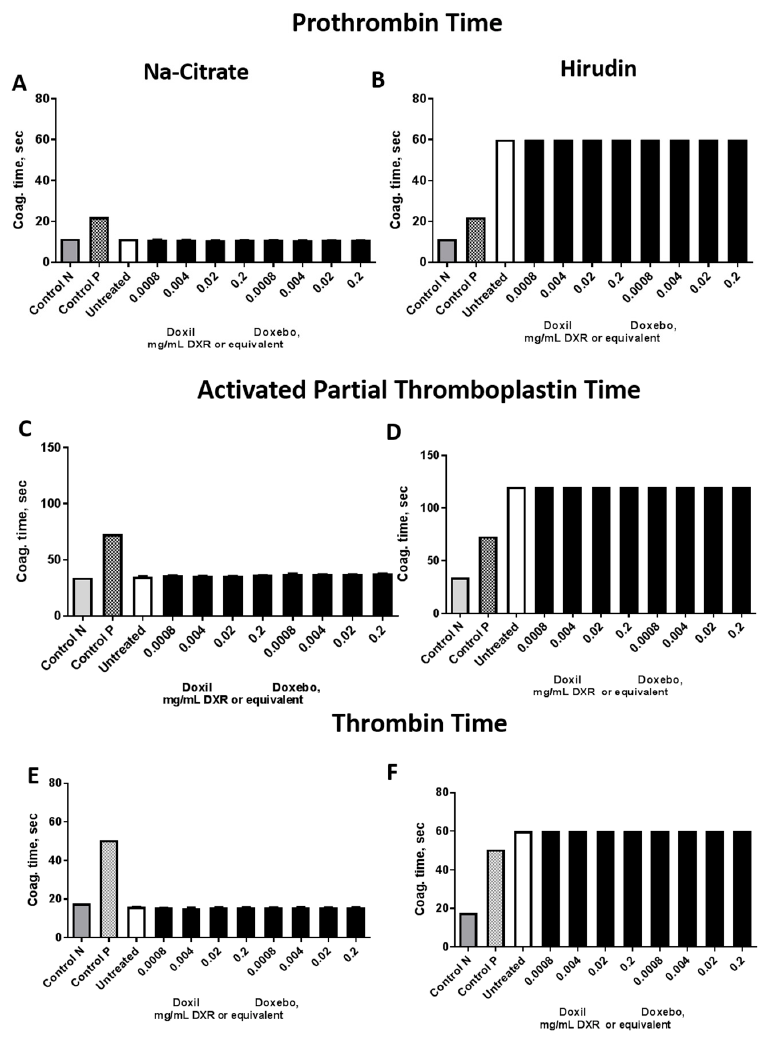
Figure 4. Plasma coagulation time. Various clinically relevant concentrations of Doxil and Doxebo were tested in prothrombin time, thrombin time, and activated partial thromboplastin time assays. For each nanoparticle concentration, three independent samples were prepared and analyzed in duplicate (%CV < 5). Each bar represents the mean ( n = 3) ± SD. Normal plasma standard (Control N) and abnormal plasma standard (Control P) were used for instrument controls. Plasma pooled from at least three donors was either untreated (Untreated) or treated with nanoparticles at the concentrations shown. Prothrombin time assay in Na-Citrate ( A ) and hirudin ( B ) anticoagulated plasma; Activated Partial Thromboplastin Time in Na-citrate ( C ) and hirudin ( D ) anticoagulated; Thrombin time assay in Na-citrate ( E ) and hirudin ( F ) anticoagulated plasma.